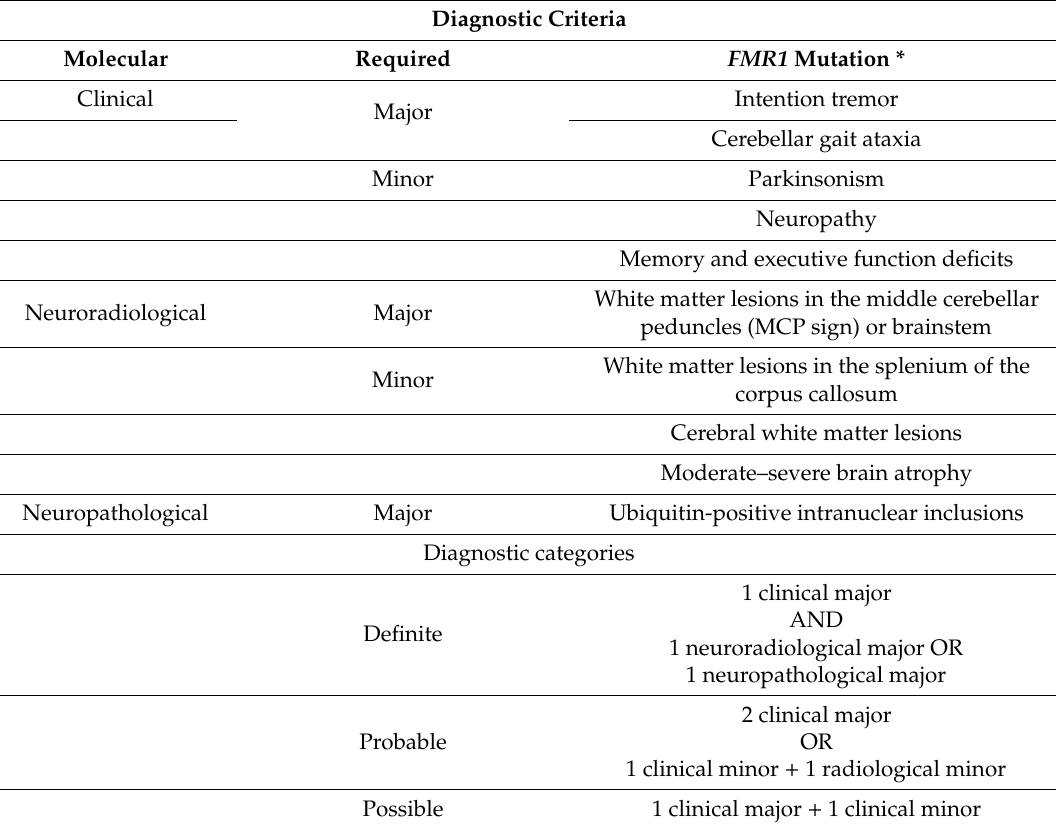
Table 1. Diagnostic criteria and categories for FXTAS. Adapted from Hall et al. 2014 [155].